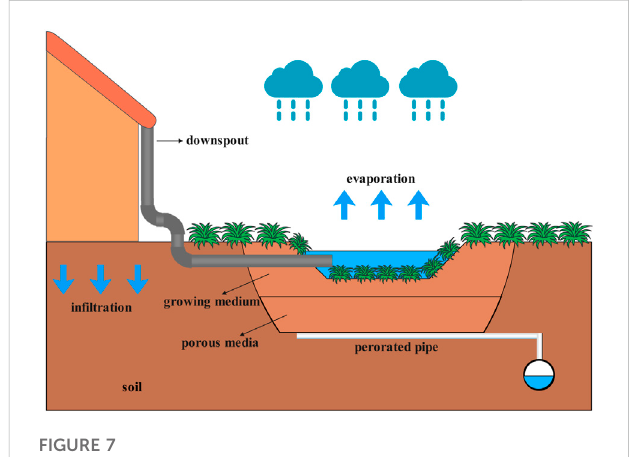
FIGURE 7 Speci fi c structure of the rainwater